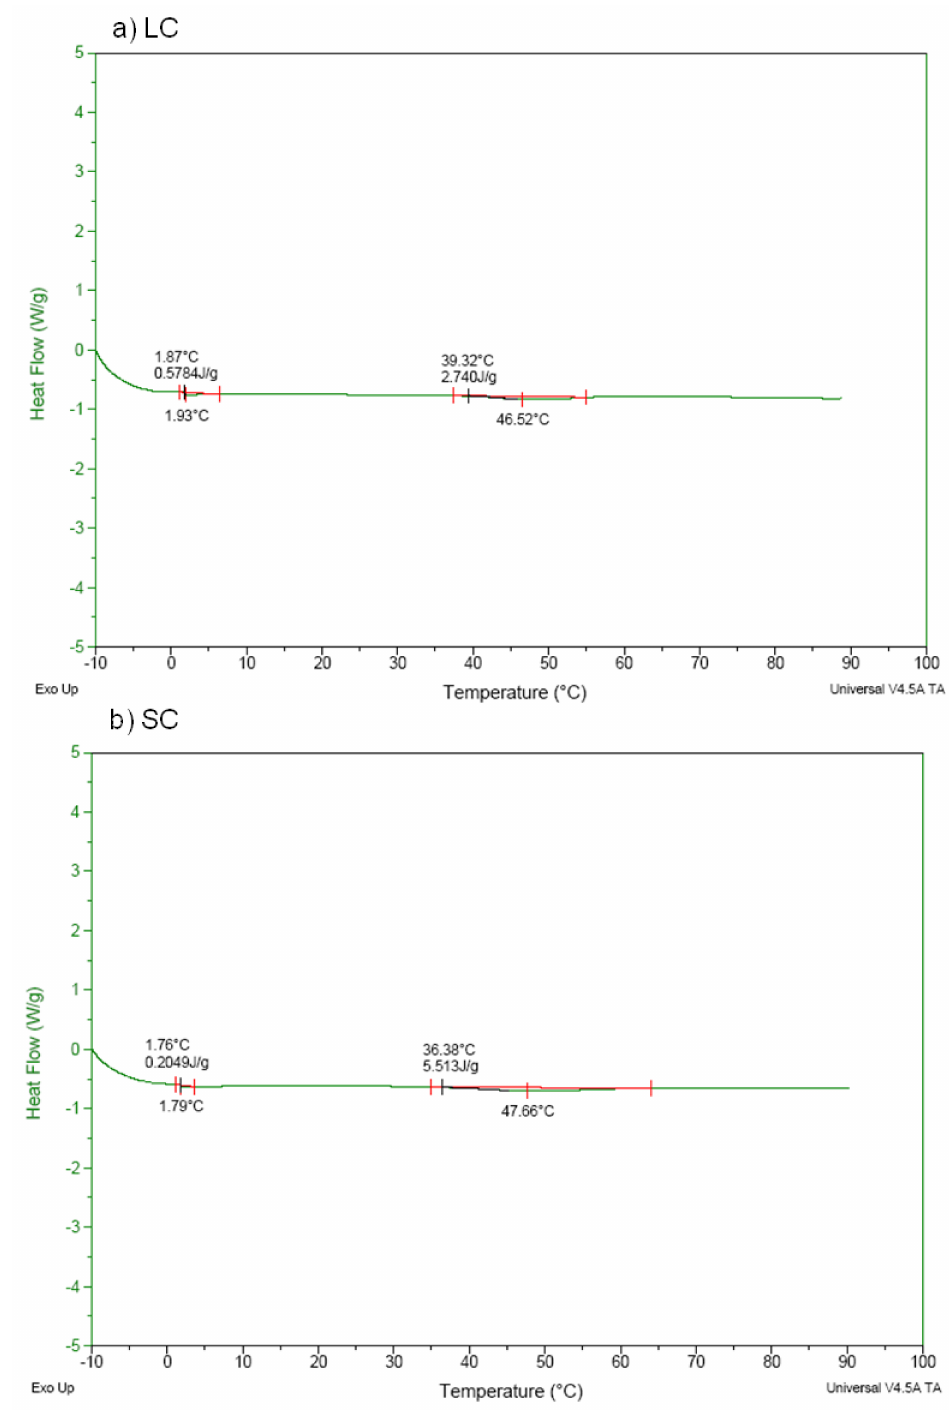
Figure 3. Differential scanning calorimetry (DSC) thermogram of the ( a ) lamb (LC) and ( b ) sheep (SC) collagen